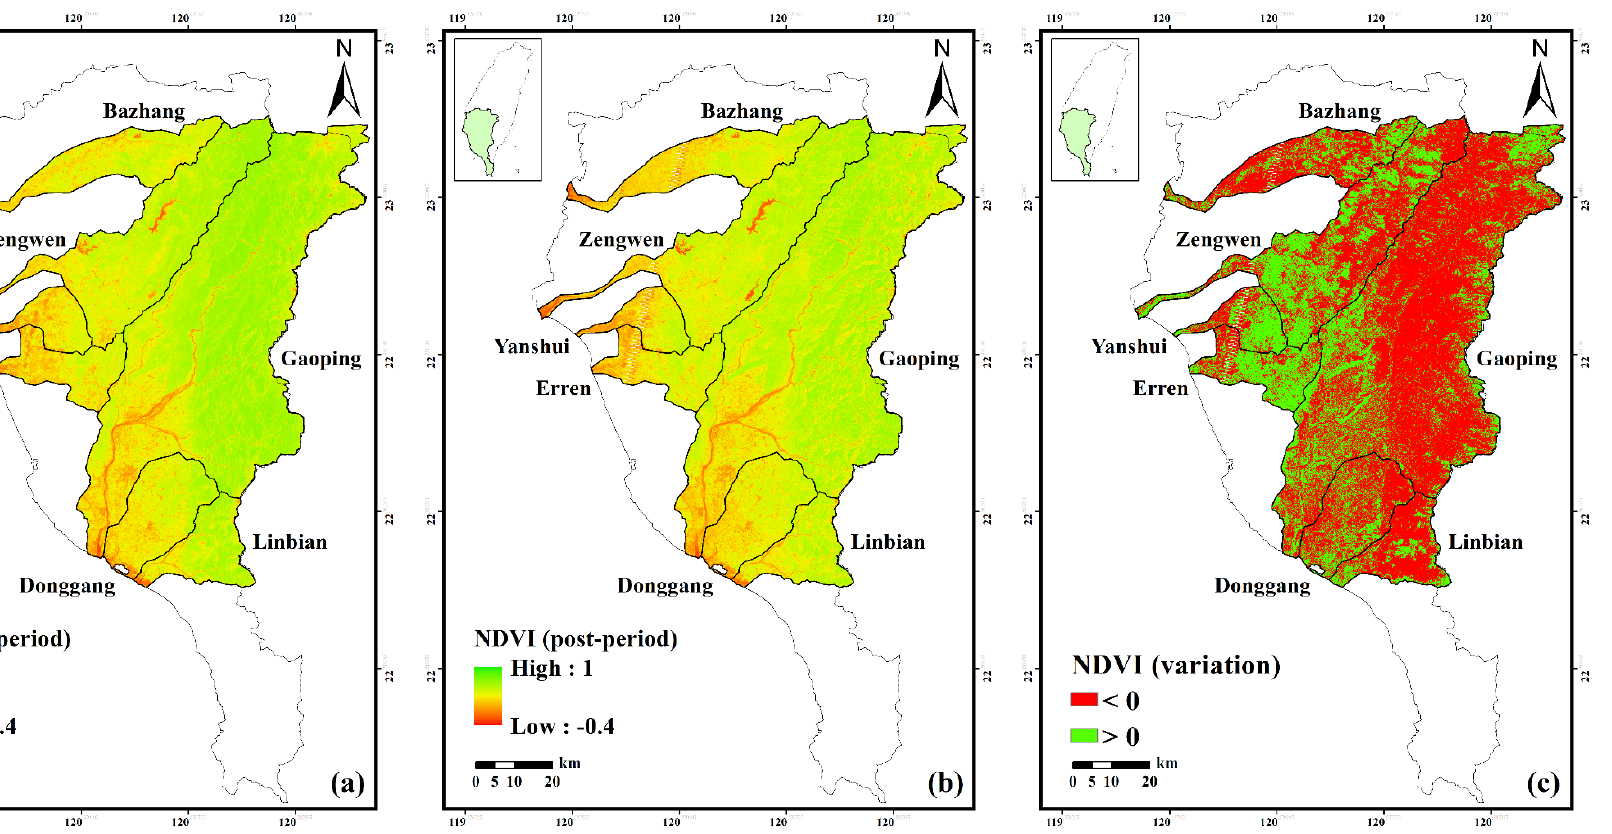
Figure 8. Spatial distribution of NDVI in seven river basins during various periods: ( a ) Pre-period, ( b ) post-period, ( c ) the variation.